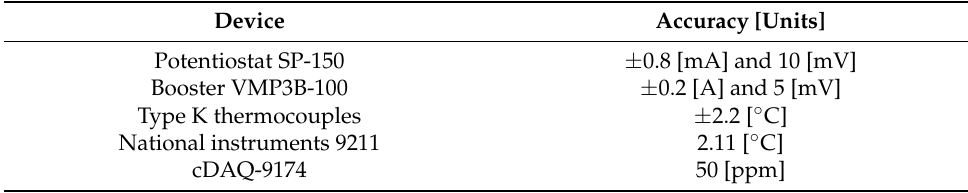
Figure 6. Test setup with the three cells battery pack. Table 2. Instrumentation